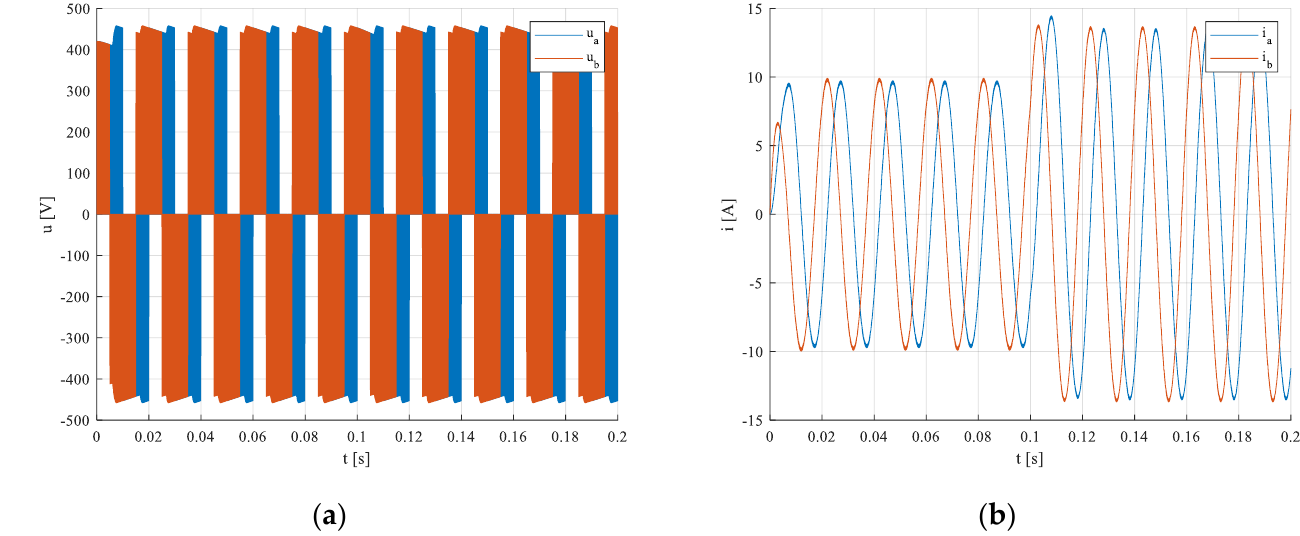
Figure 24. VSI inverter voltages ( a ) and currents ( b ) in 𝑎, 𝑏, resp. in 𝛼, 𝛽 - systems during the transient.